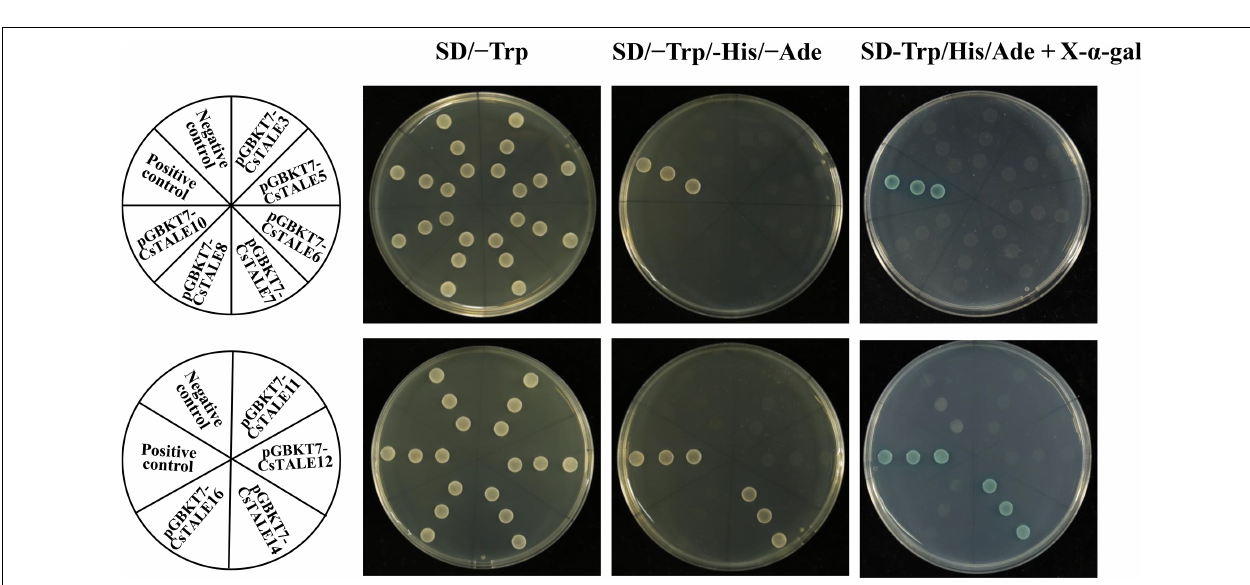
FIGURE 7 | Transcriptional activation of CsTALEs. Transactivational analyses. Fusion constructs (pGBKT7-CsTALE) and negative control (pGBKT7 empty vectors), were transformed into yeast AH109 strain and incubated in SD/-Trp, SD/-Trp/–His/-Ade and SD-Trp/His/Ade + X- α -gal medium.